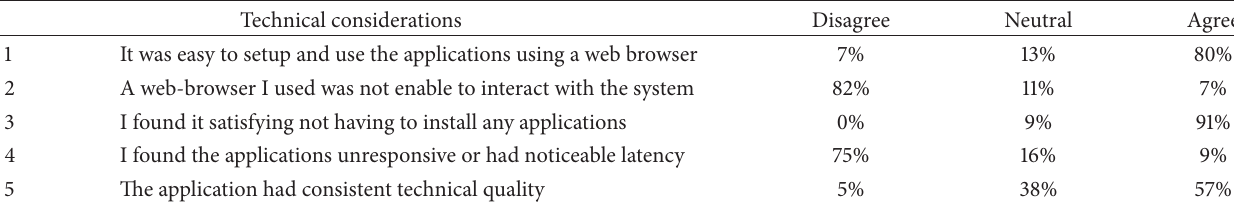
Table 4: Results from technical